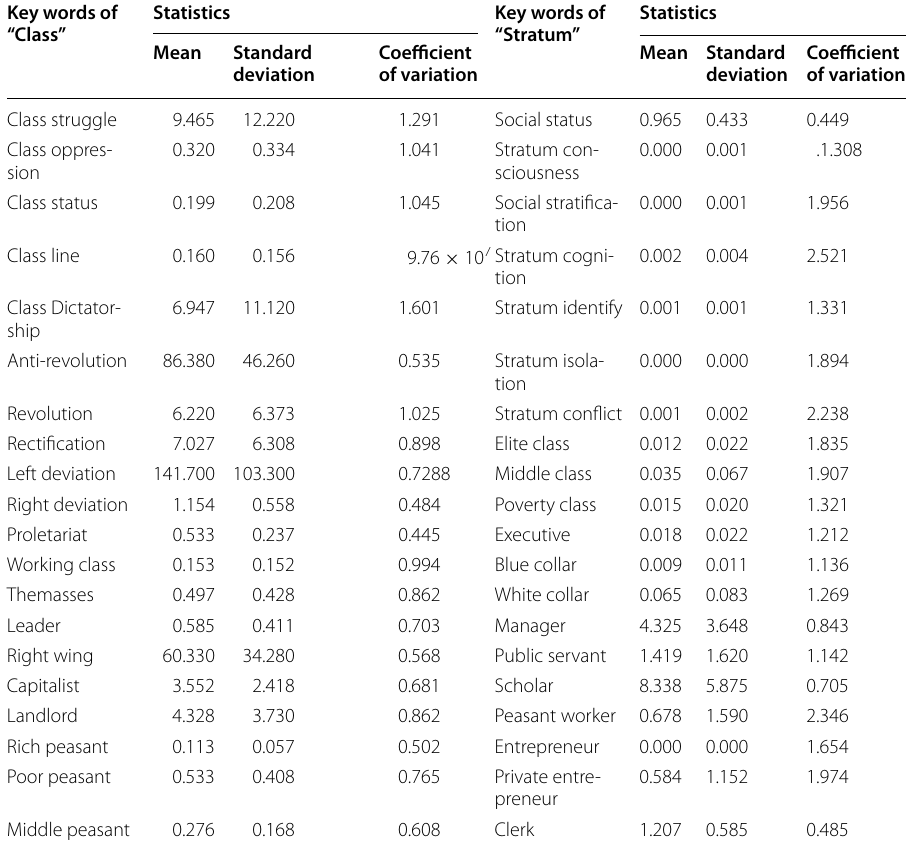
Table 1 Descriptive statistics of class- and stratum-related words in Google Books (simplified Chinese),